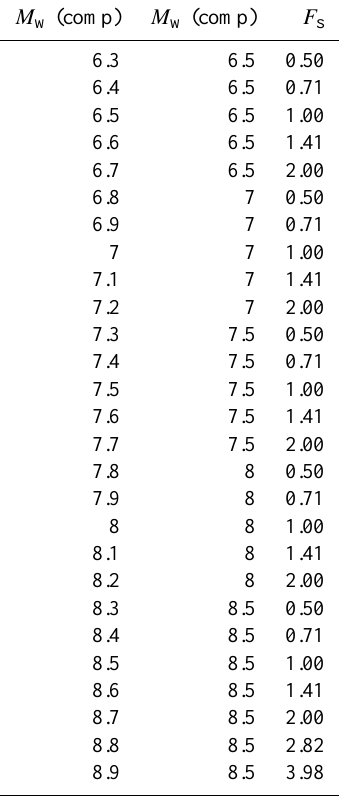
Table 4. Scaling factors ( F s ) required to produce a new arbitrary scenario of Magnitude M w ( comp) from the existing M w = 6 . 5, 7.0, 7.5, 8.0 and 8.5unit source functions in the NE Atlantic